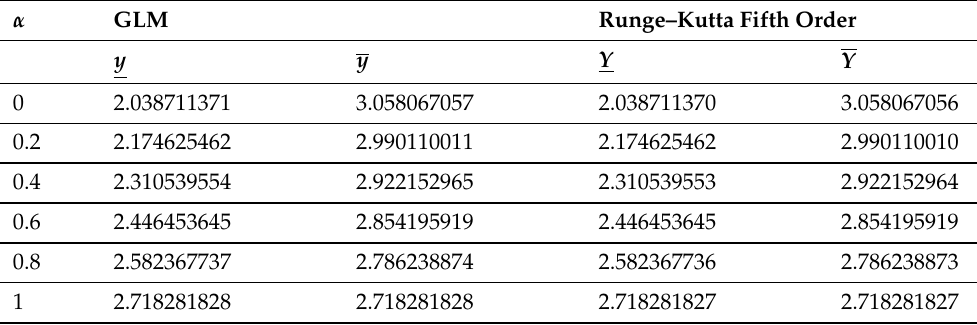
Table 10. Comparison between the GLM and the Runge–Kutta fifth order for the 1-solution at t =